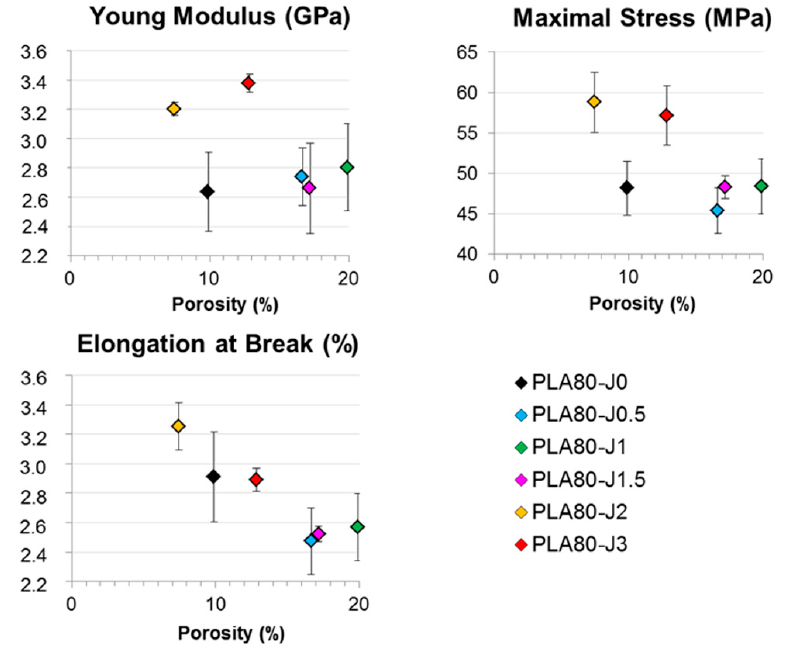
Figure 12. Mechanical properties as a function of porosity for FDM printed samples.